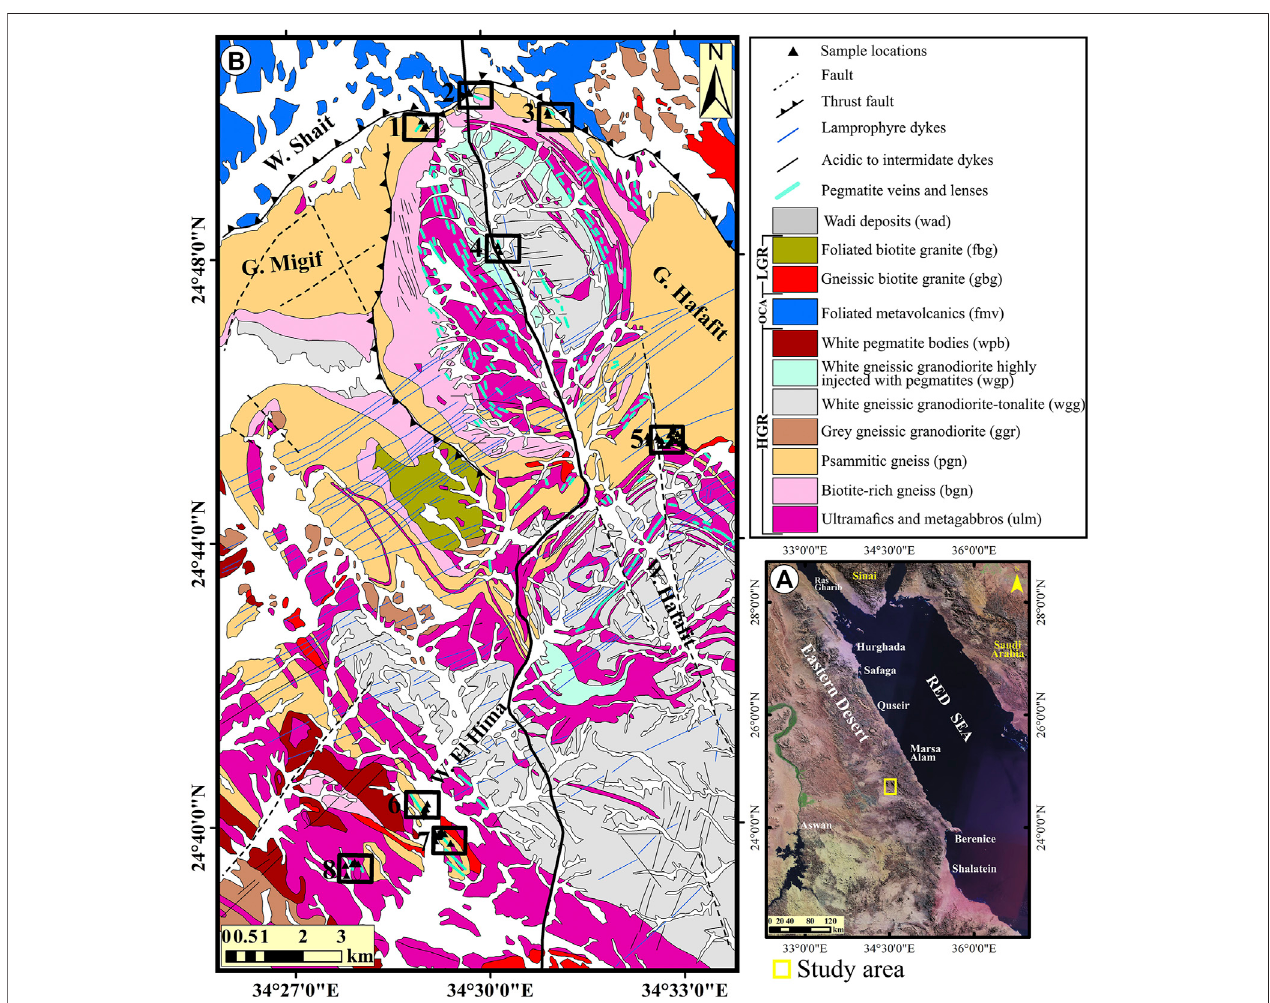
FIGURE 1| (A) Location map ofthe study areaand (B) Detailed geological map of Migif-Hafa fi t area(updated and modi fi ed after El Ramly and Greiling, 1988). The black boxes represent the location of the eight studied areas, which were selected to detect corundum-bearing pegmatites and host rocks. 1: Um Karba, 2: Wadi El Qarn, 3: Um Maiat, 4: Abu Merikhat, 5: Um Nimr, 6: North El Hima, 7: Um Shegera and 8: South El Hima. HGR = Migif-Hafa fi t gneisses and associated rocks, OCA = Ophiolitic and Calc-alkaline assemblages, and LGR = Late granitoid. The thick black line represents asphaltic road from Marsa Allam to El-Sheikh